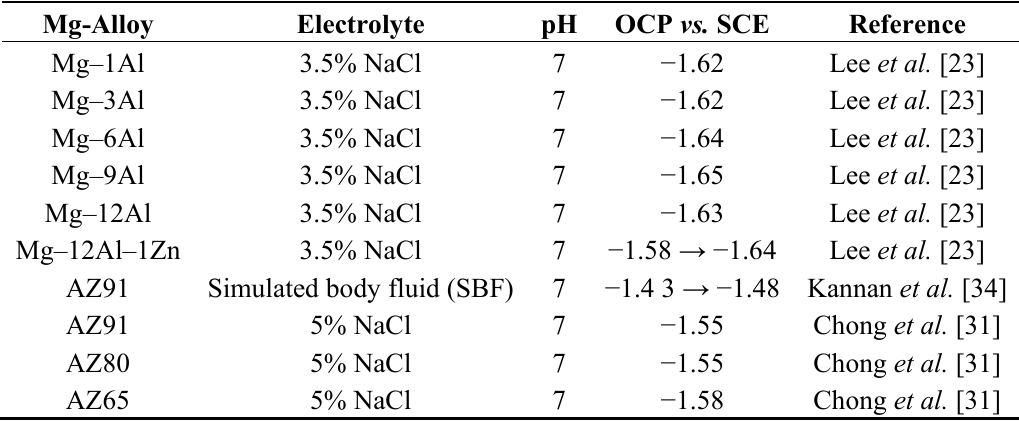
Table 4. Mg–Al alloys and Mg–Al–Zn